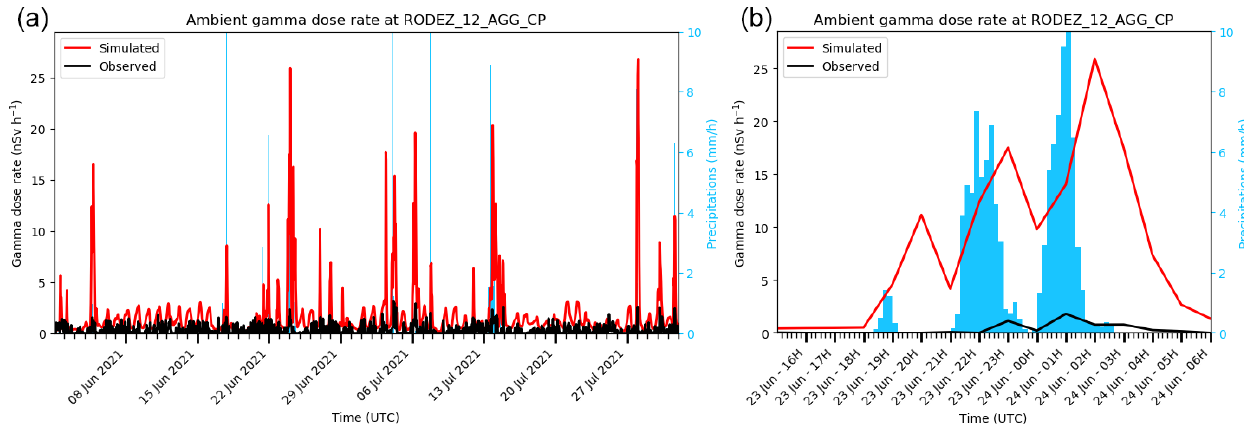
Figure 10. Observed and simulated ambient gamma dose rates at the Lumbres station in 2021.